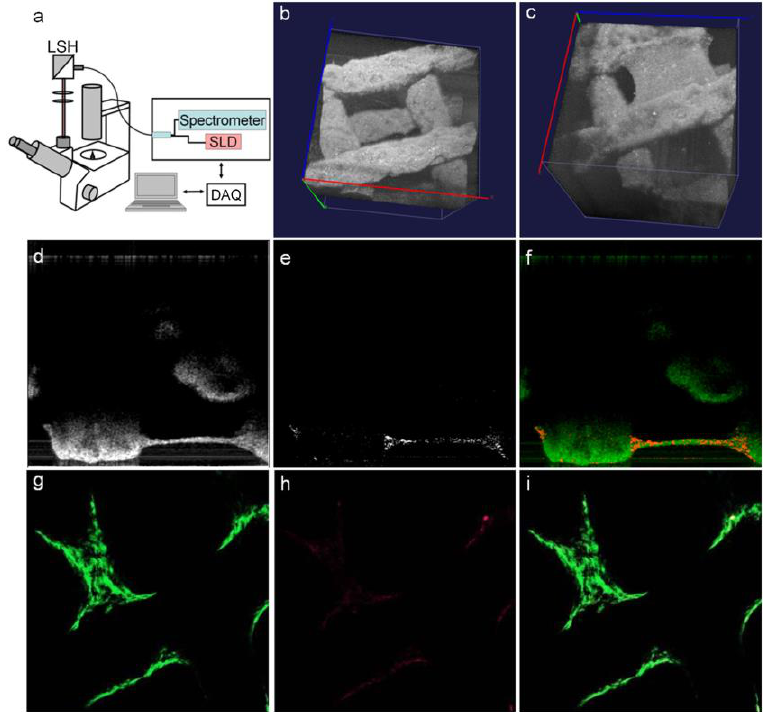
Figure 10. ( a – i ) OCT design and the tracking of cells in a 3D bioprinted scaffold seeded with cells. Reproduced with permission from Ref. [127].